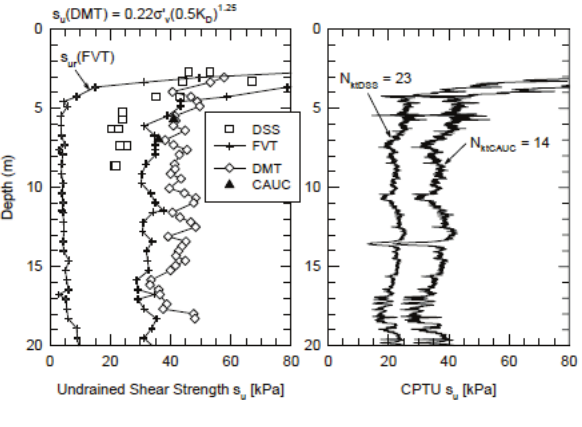
Fig. 2. Undrained shear strength data from laboratory recompression tests (DSS, CAUC) and in situ tests (FVT, DMT, CPTU) [6]